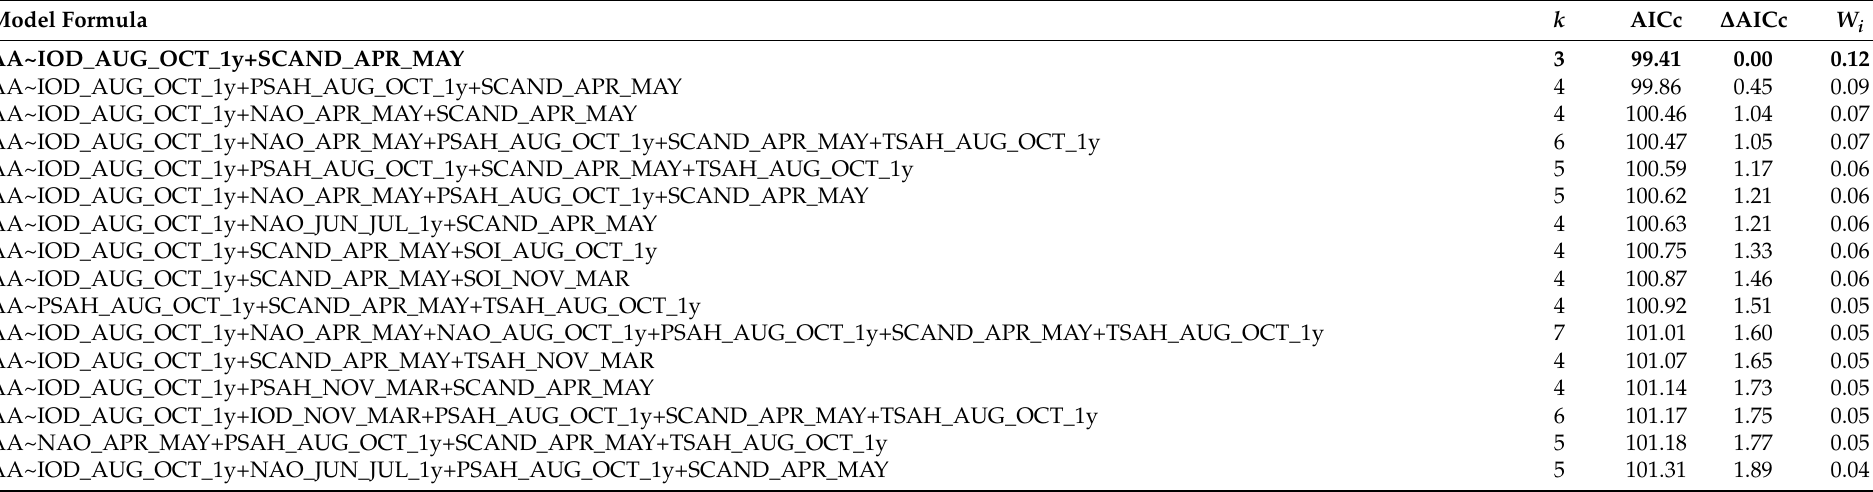
Table A23. Model selection procedure by “all subsets”, according to AICc, from the full model of the relationship between the 15 climate variables and the year, and the overall timing of migration as measured by Annual Anomaly (AA) for the Chiffchaff Phylloscopus collybita caught at Bukowo, Poland, in 1982–2017. Symbols as in Table A19. The best model, discussed in the text, in bold